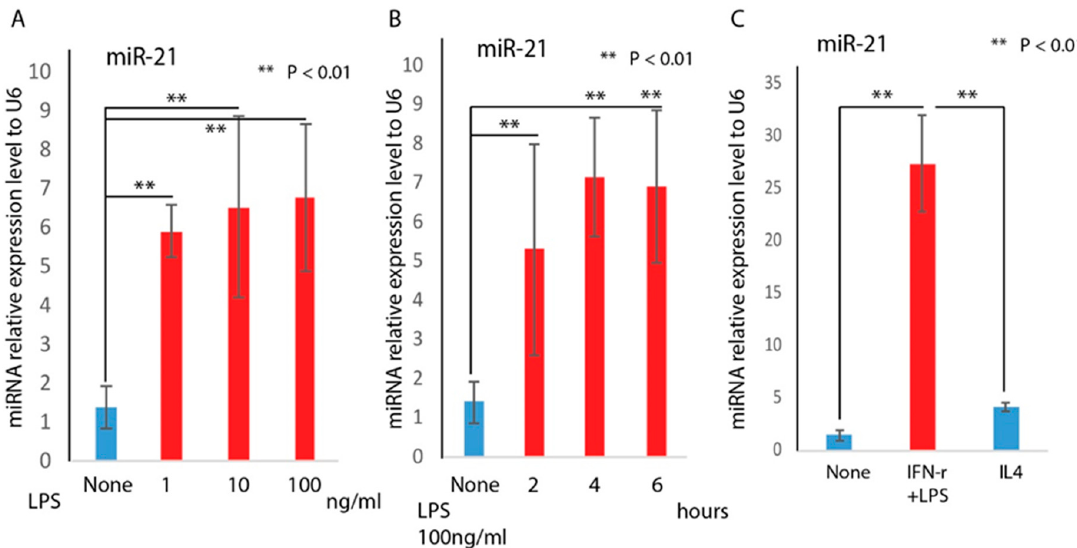
Figure 3. MiR-21 is highly induced in M1 macrophage. RAW cells were treated with LPS at 1, 10, and 100 ng/mL and compared to non-treated RAW cells. RAW cells were also treated with LPS at 100 ng/mL for 2, 4, and 6 h. MiR-21 was significantly induced by LPS in a dose- ( A ) and time-dependent ( B ) manner confirmed by real-time PCR analysis (mean + SD, n = 3 per group); ( C ) RNA analyses by